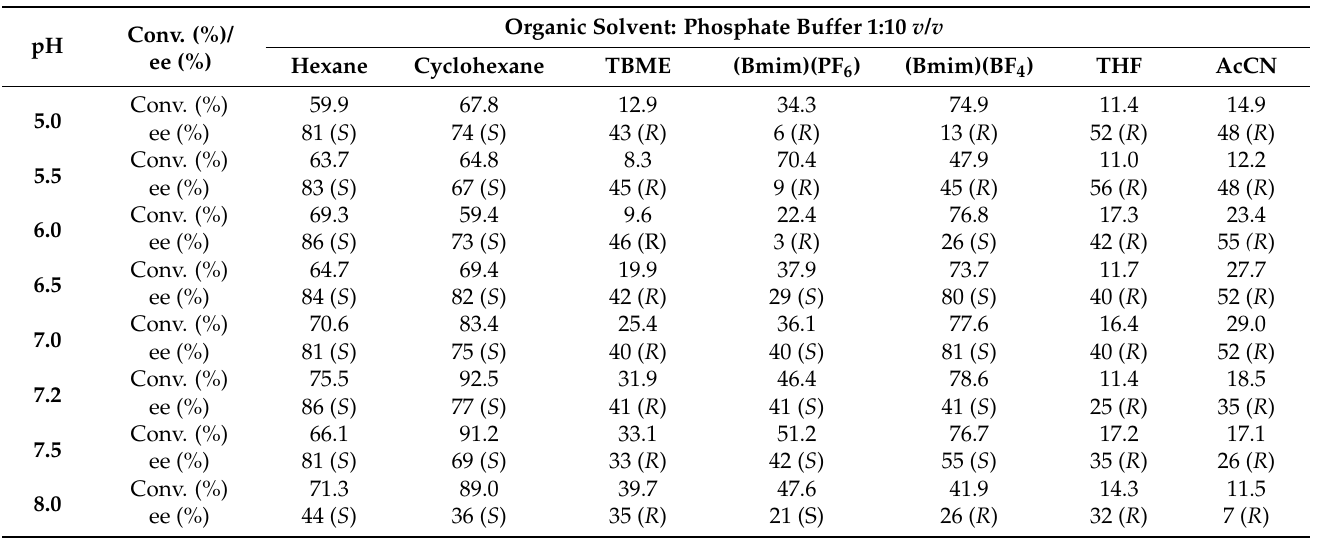
Table 5. Bioreduction of 1 Catalyzed by A. pullulans Strain DSM 14940 and DSM 14941 in a Two Liquid-Phase Systems. Organic Solvent: Phosphate Buffer 1:10 v / v Conv. (%)/ pH ee (%) Hexane